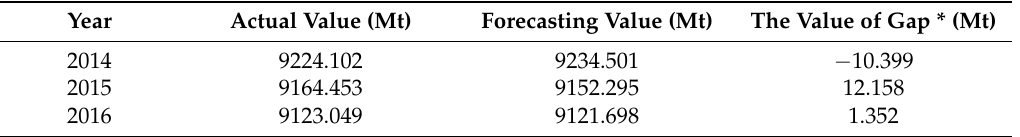
Table 2. Forecasting values and gaps of CO 2 emissions of the SSA-LSSVM